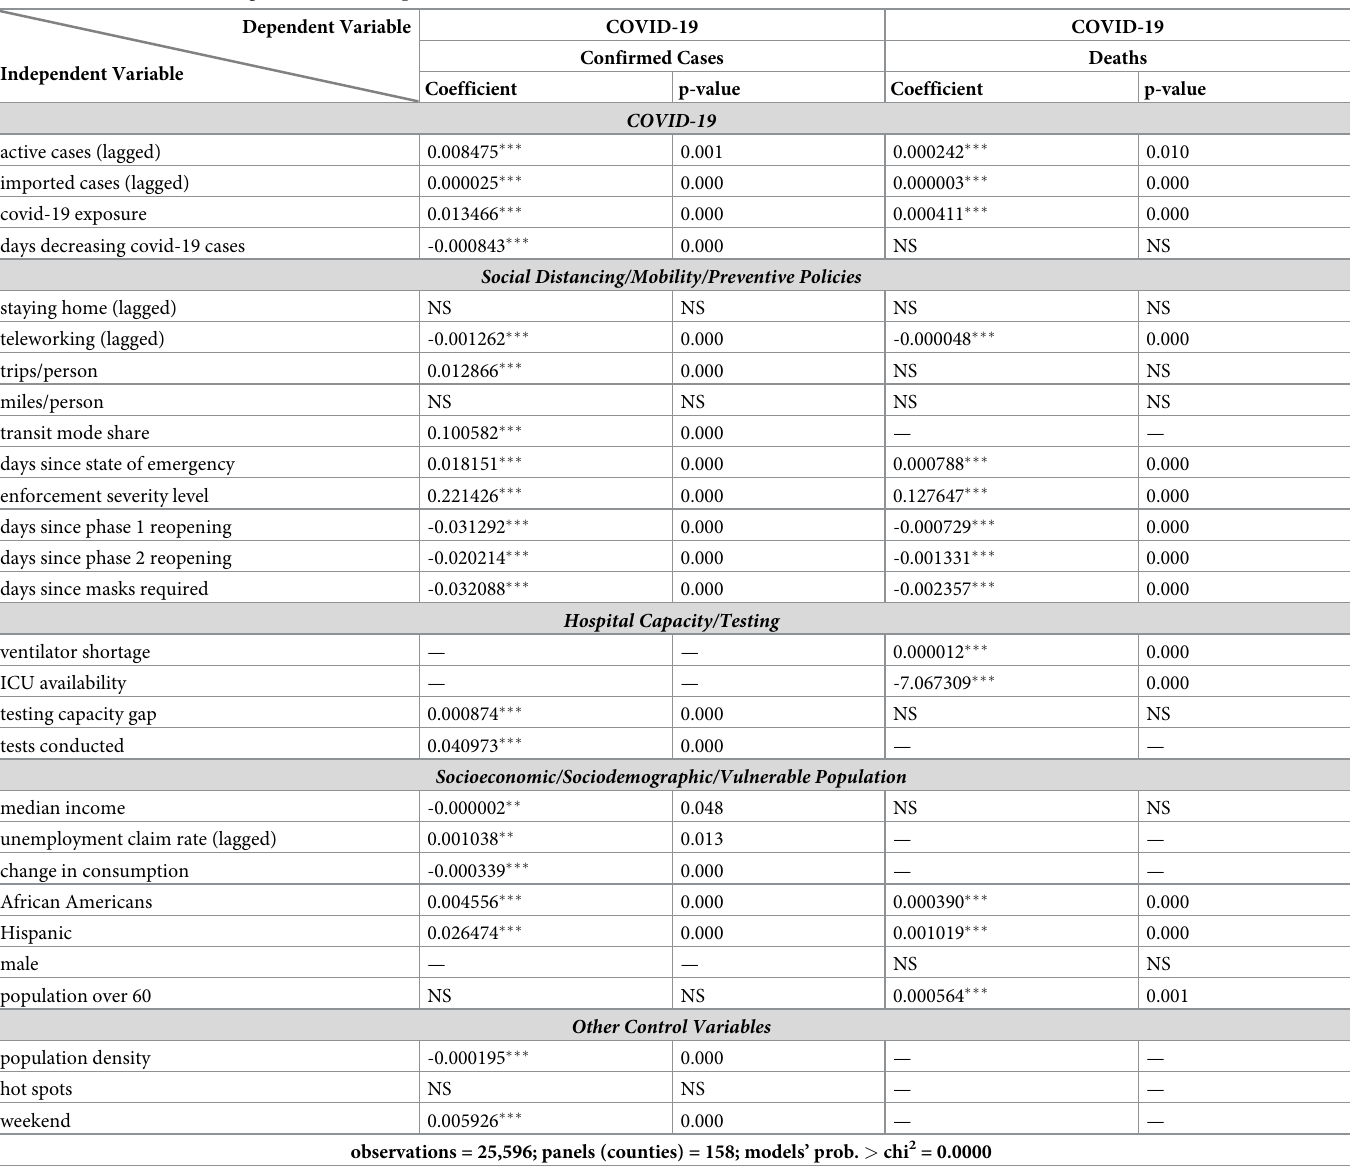
Table 2. Panel model results (generalized least squares